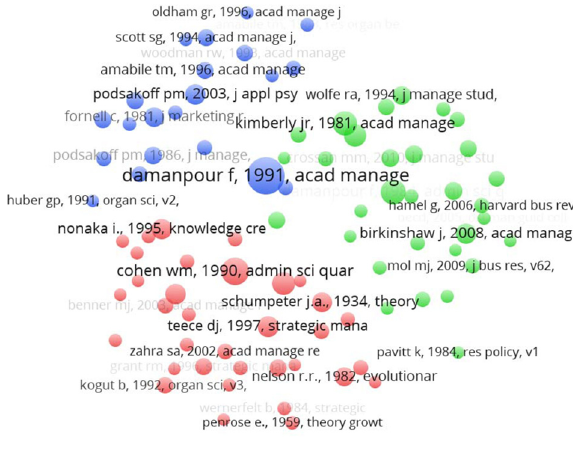
Figure 1. Co-citation cluster